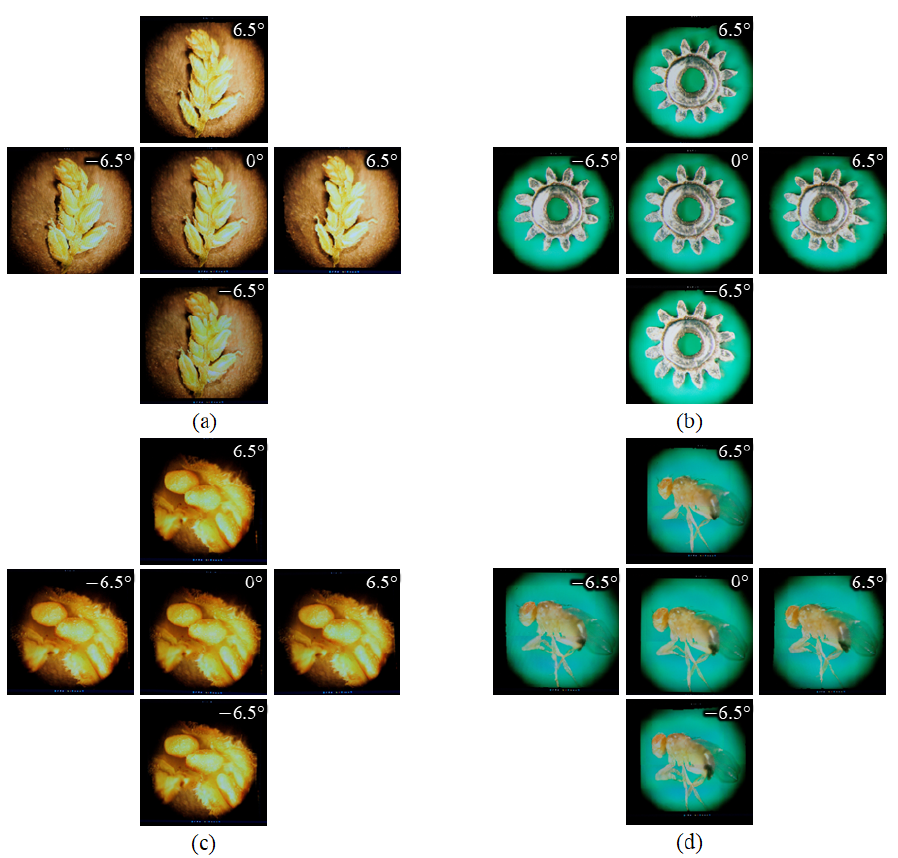
Figure 12. Five viewpoints of the reconstructed 3D images from the newly generated EIAs, for ( a ) a